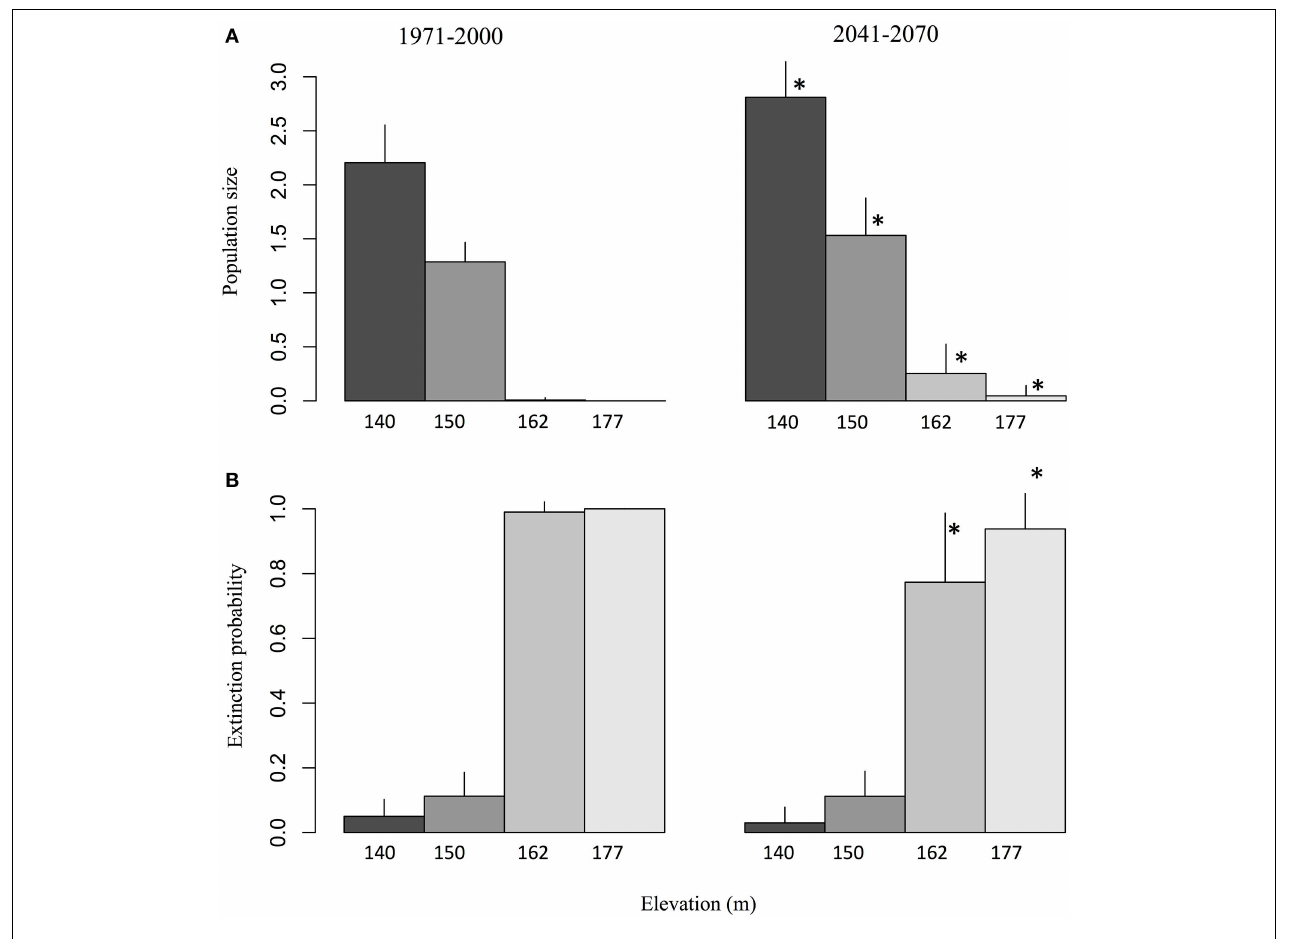
FIGURE 5 | (A) Salamander population size and (B) extinction probability observed over a spring of 4m 2 during the reference and future periods, given the projected activity time series for elevations of 140, 150, 162, and 177m. The values correspond to ensemble averages and error